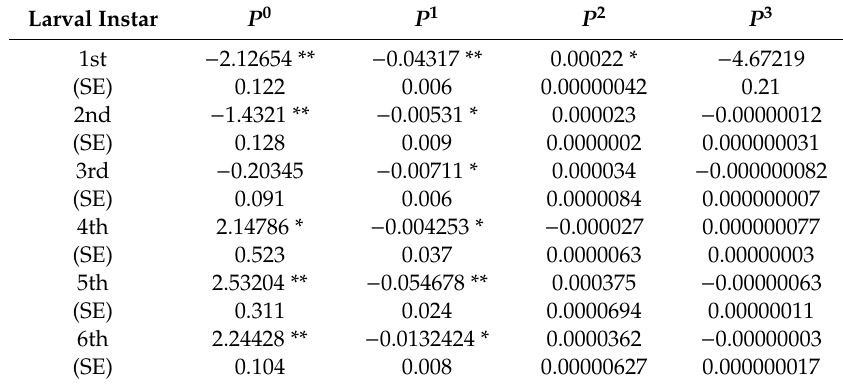
Table 1. Maximum likelihood estimates ( ± SE) for parameters of the logistic model fit to proportion of prey consumed versus initial prey density.